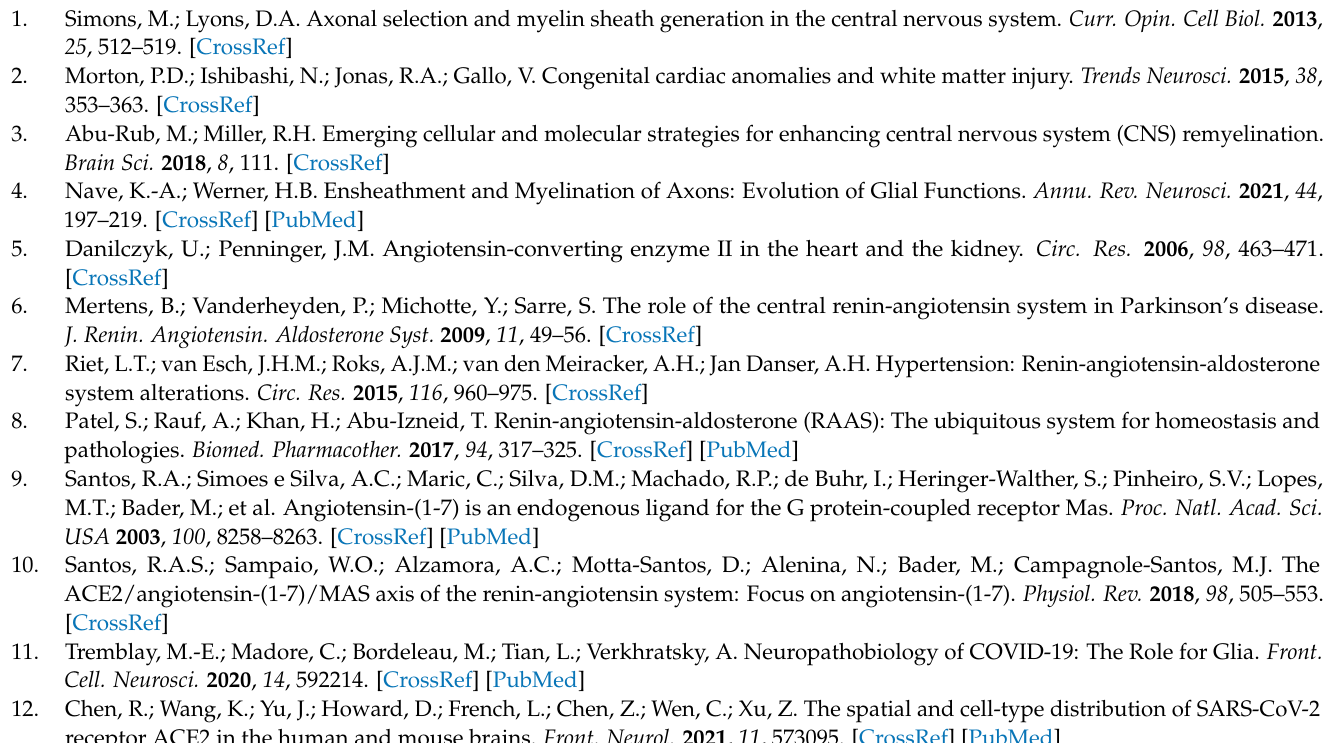
Figure S2. ACE2 inhibition slightly promotes morphological differentiation in primary oligodendro- cyte precursor cells.; Figure S3. ACE2 inhibition slightly promotes oligodendroglial cell morphological differentiation in FBD-102b cells.; Figure S4. The intracellular domain of ACE2 preferentially inter- acts with phosphatidylinositol-3 kinase α in a guanine-nucleotide-dependent manner.; Figure S5. The intracellular domain of ACE2 preferentially interacts with phosphatidylinositol-3 kinase β in a guanine-nucleotide-dependent